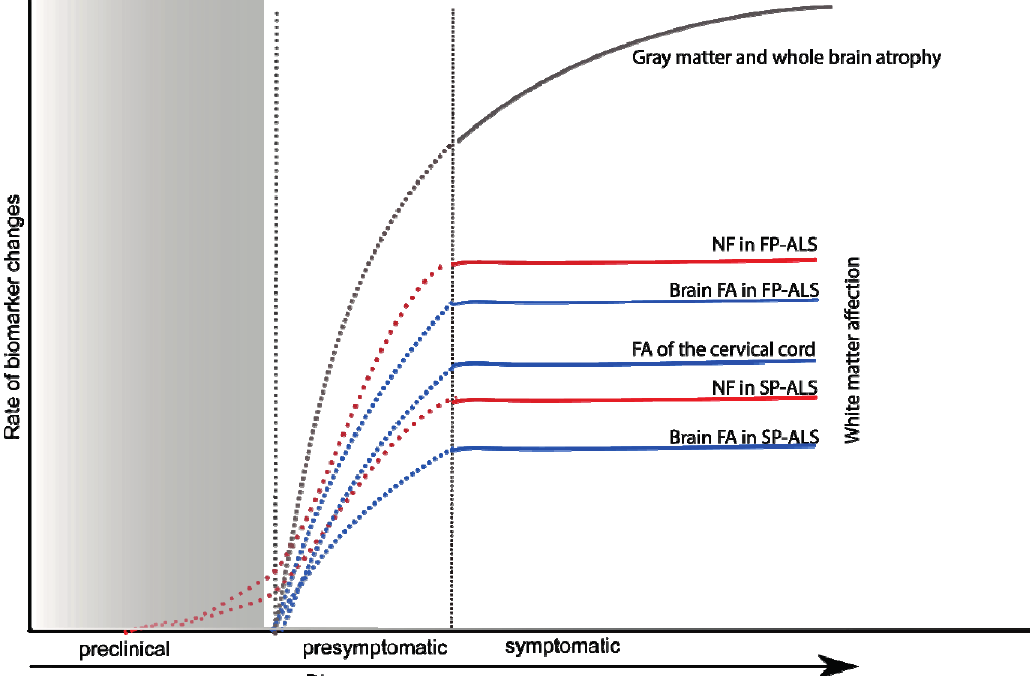
Figure 3. Dynamics of changes in the CSF and MRI-parameters of neurodegeneration over the course of the ALS. In different longitudinal imaging studies, the Fractional Anisotropy (FA) was relatively stable, but different between patients with fast (FP-ALS) and slow (SP-ALS) progressive ALS. The same studies showed progressive atrophy of the cortical grey matter and spinal cord in the symptomatic stages. This suggests that the major damage of corticospinal tract occurs in the presymptomatic stage of the disease. Accordingly, the rate of changes in FA and neurofilaments (NF) in the CSF would be greater in the presymptomatic stage rather than after appearance of the